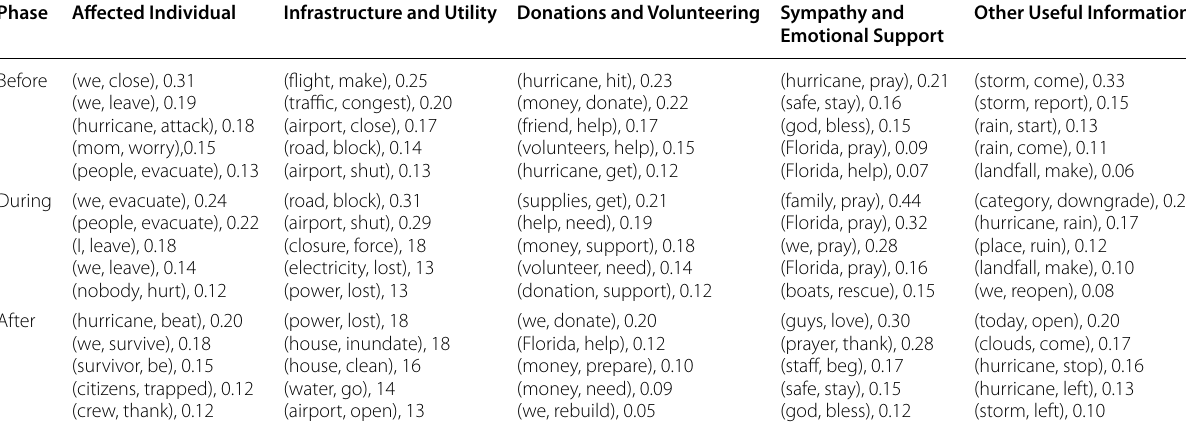
Table 5 Action-level situational awareness over different phases (top 5) Phase Affected